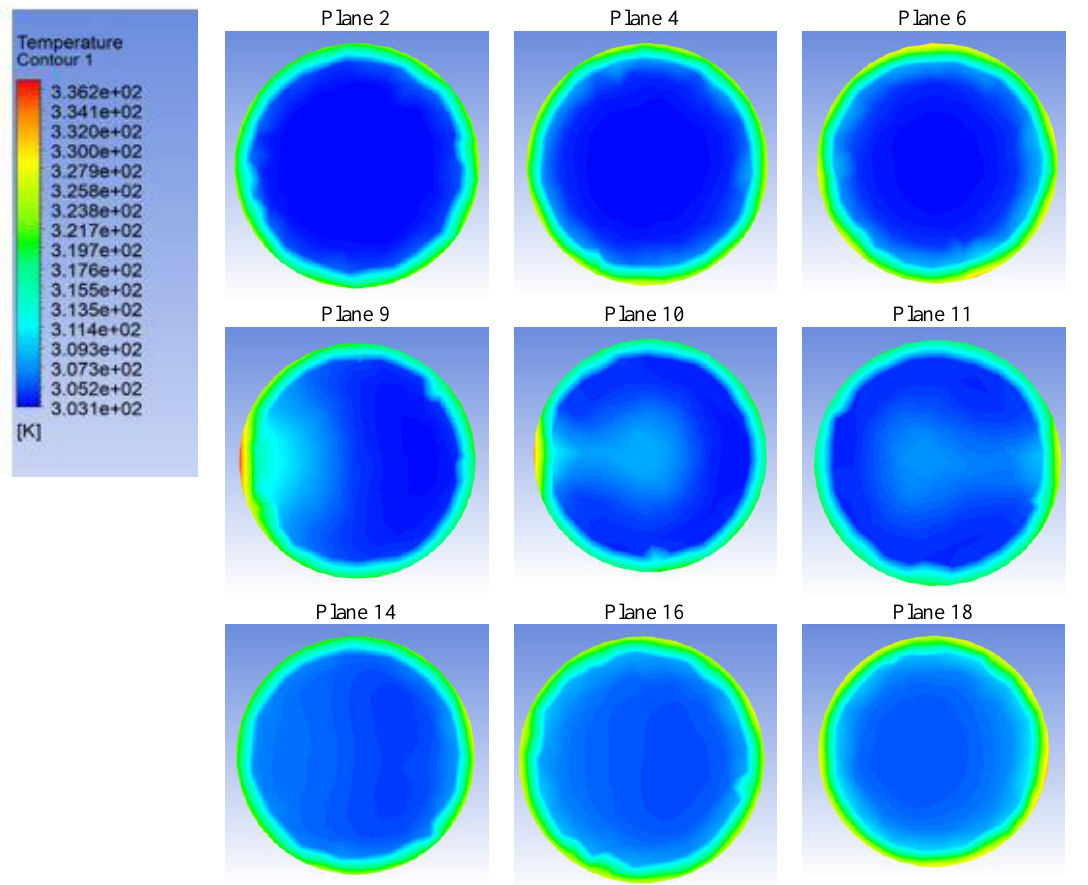
Figure 15. Temperature contour distribution at each plane location using fruit juice.